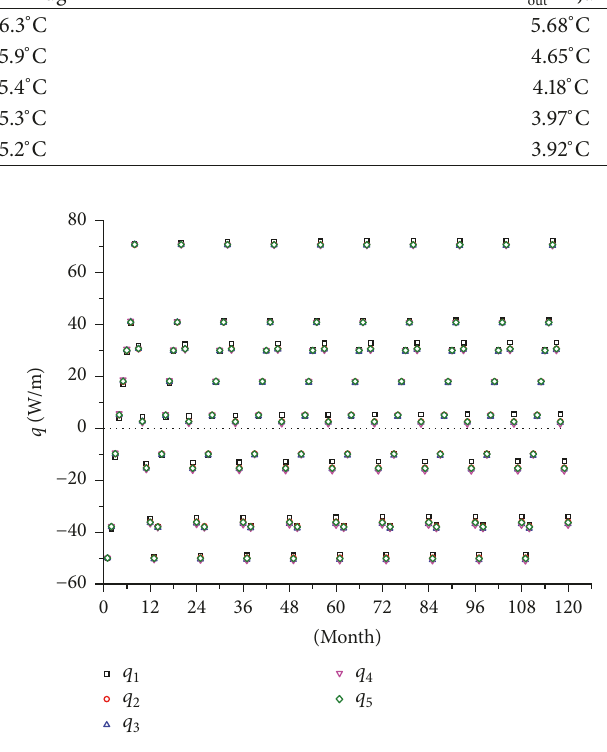
Figure 11: Monthly average heat fluxes for different boreholes ( 𝜃 = 𝜋/4 ). Figure 12: Monthly average heat fluxes for different boreholes ( 𝜃 =